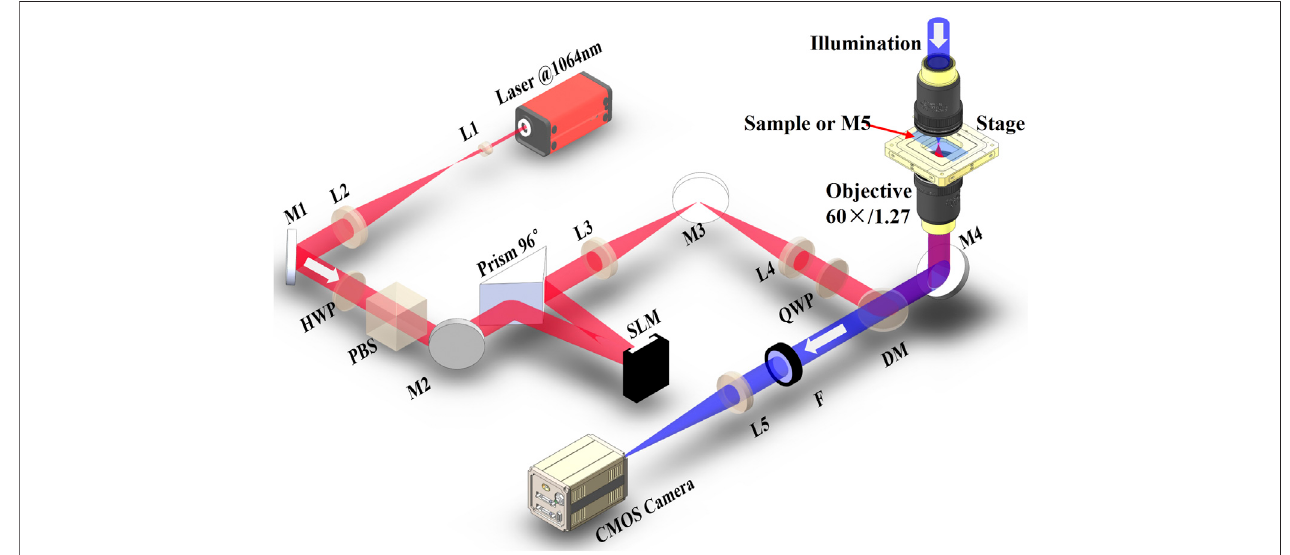
FIGURE 4 | Schematic diagram of the holographic optical tweezers system used to generate HOTAs. L, lens; M, mirror; HWP, half-wave plate; PBS, polarizing beam splitter; QWP, quarter-wave plate; DM, dichroic mirror; F, fi lter; SLM, spatial light modular; CMOS, complementary metal oxide semiconductor.